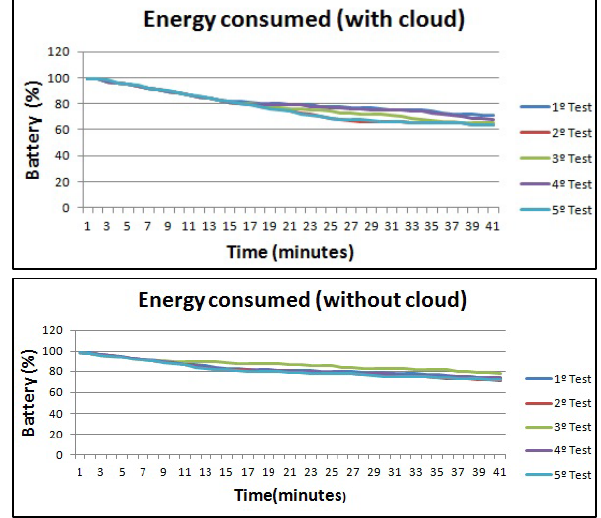
Figure 4. Energy Consumed, with and without cloud.